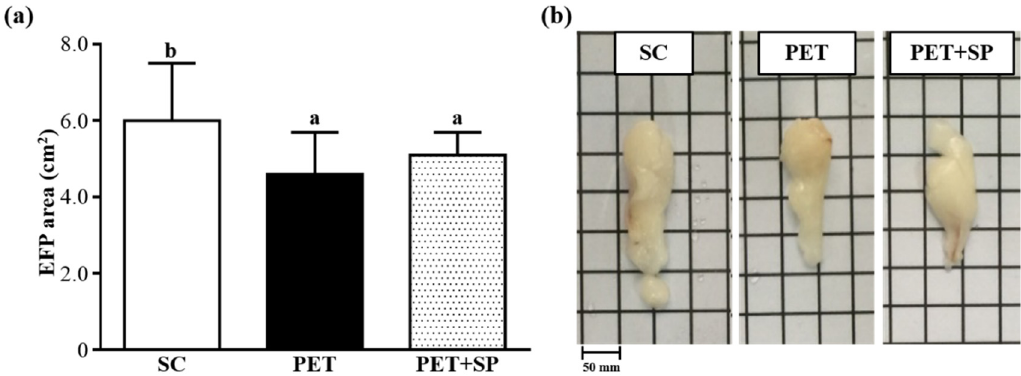
Figure 3. Effect of SP supplementation and four-week PET on ( a ) epididymal fat pad (EFP) area (cm 2 ). ( b ) View of EFP. Data are mean ± SD of eight mice in each group by one ‐ way ANOVA. Different letters (a, b) indicate a significant difference at p < 0.05.